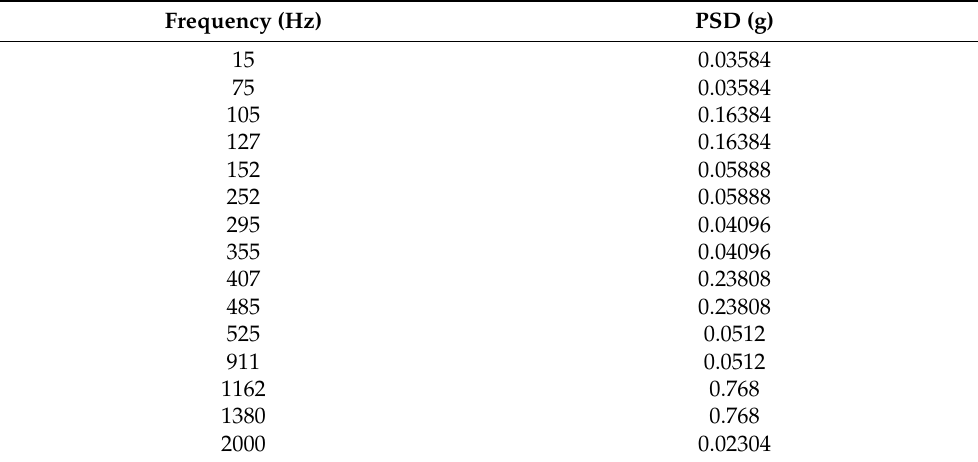
Table 1. Parameters of the airborne level random vibration profile used in this paper root-mean- square acceleration = 20.64 g.